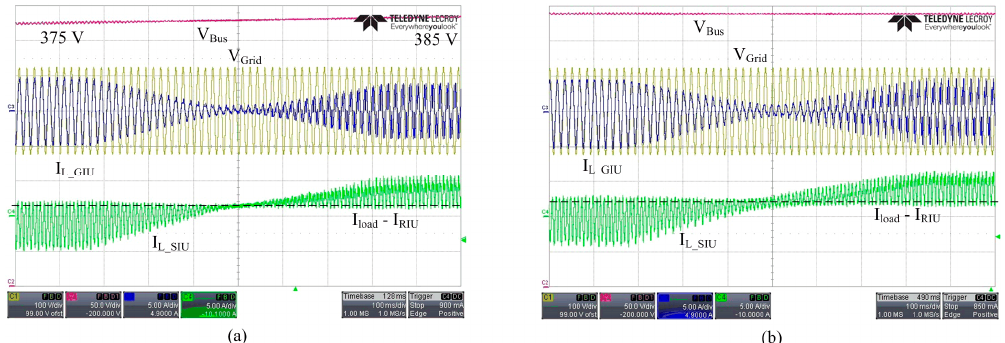
Figure 13. Experimental waveforms of the proposed system when the battery SoC level changes from 10% to 90% ( a ) without voltage restoration and ( b ) with voltage restoration.